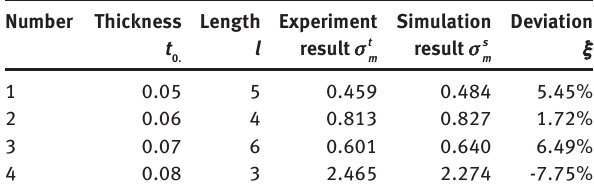
Figure 3: The compression stress of R0-HC and R2-HC. Table 3: Comparison between simulation results and experiment for R0-HC.